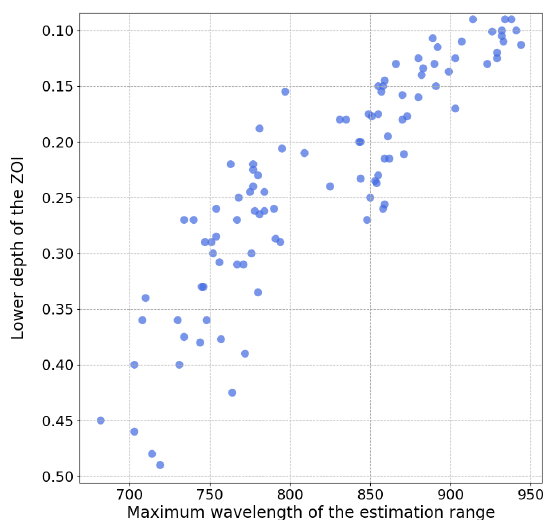
Figure 4. Upper limit of the spectral range where the AFEC esti- mation shows a signal-to-noise ratio over 15 for the whole dataset (100